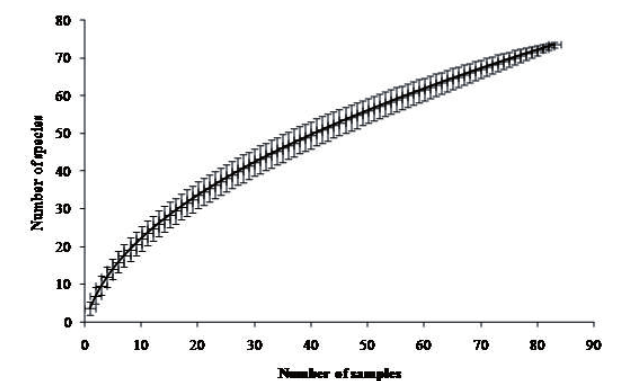
Fig 1 . Rarefaction curve representing the cumulative number of spe - cies sampled in function of the quantity of samples in Semideciduous Forest of "Fazenda São José", Uberlândia-MG, in 2010 and 2011.